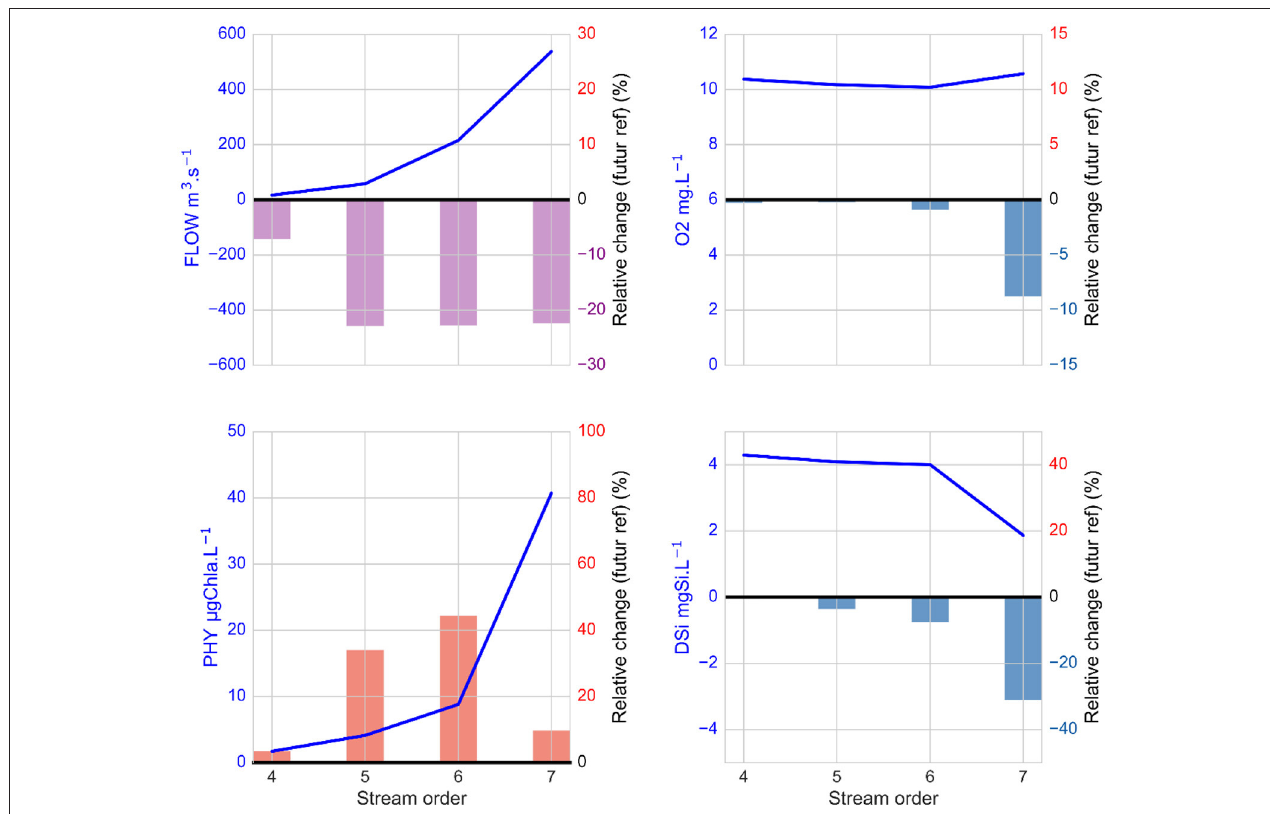
FIGURE 6 | Spatial impacts of climate change on relative changes in streamflow, phytoplankton, dissolved oxygen and silicic acid concentrations in May in each Strahler order category of the Seine River basin with the driest scenario, RCP8.5 (ICHEC85_CLMcom). The relative change is the difference between 21-year averages for 2080–2100 and for the 1980–2000 reference period, averaged by order. The relative decrease in flow is indicated in violet and the relative positive and negative changes for other variables are indicated in red and blue, respectively. The reference values are represented by the blue